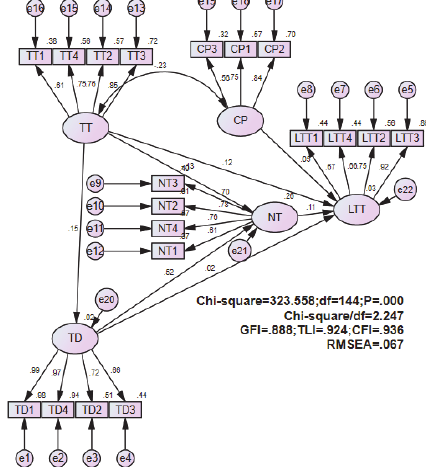
Fig. 2. Results of the structural model analysis show effects of attitude, trust, switching cost to loyalty at commercial banks in Ho Chi Minh city TT (Hedonic attitude), TD (Utilitarian attitude), NT (Trust), CP (Switching cost), LTT (Loyalty) Source: AMOS Analysis Results.